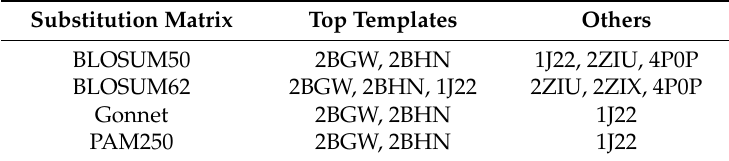
Table 1. Results from different substitution matrices available in MOE 2013 for the detection of homologs of the human XPF nuclease domain. Proteins are reported with their PDB ID. See text for more details. Substitution Matrix Top Templates Others BLOSUM50 2BGW, 2BHN 1J22, 2ZIU, 4P0P BLOSUM62 2BGW, 2BHN, 1J22 2ZIU, 2ZIX, 4P0P Gonnet 2BGW, 2BHN 1J22 PAM250 2BGW, 2BHN